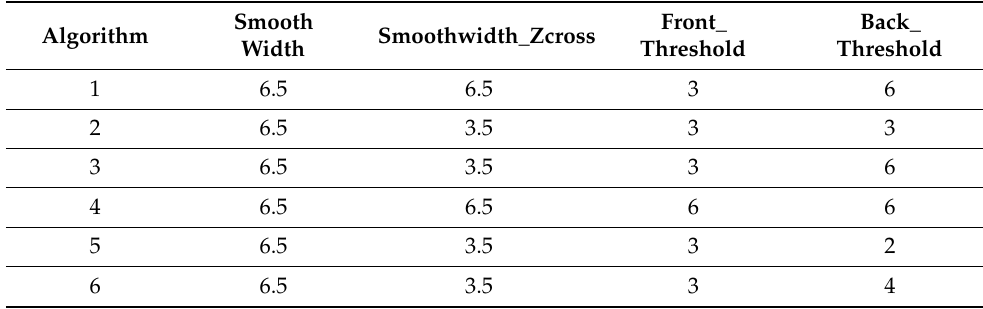
Table A1. The different parameters used in each of the six algorithms for the interpretation of the re- ceived waveforms. Smooth_width is the width used for the first Gaussian filter. Smoothwidth_zcross is the width of the Gaussian filter used before the first order derivative of the waveform to detect the modes. Front_threshold and Back_threshold are the thresholds used to find the signal start and signal end,